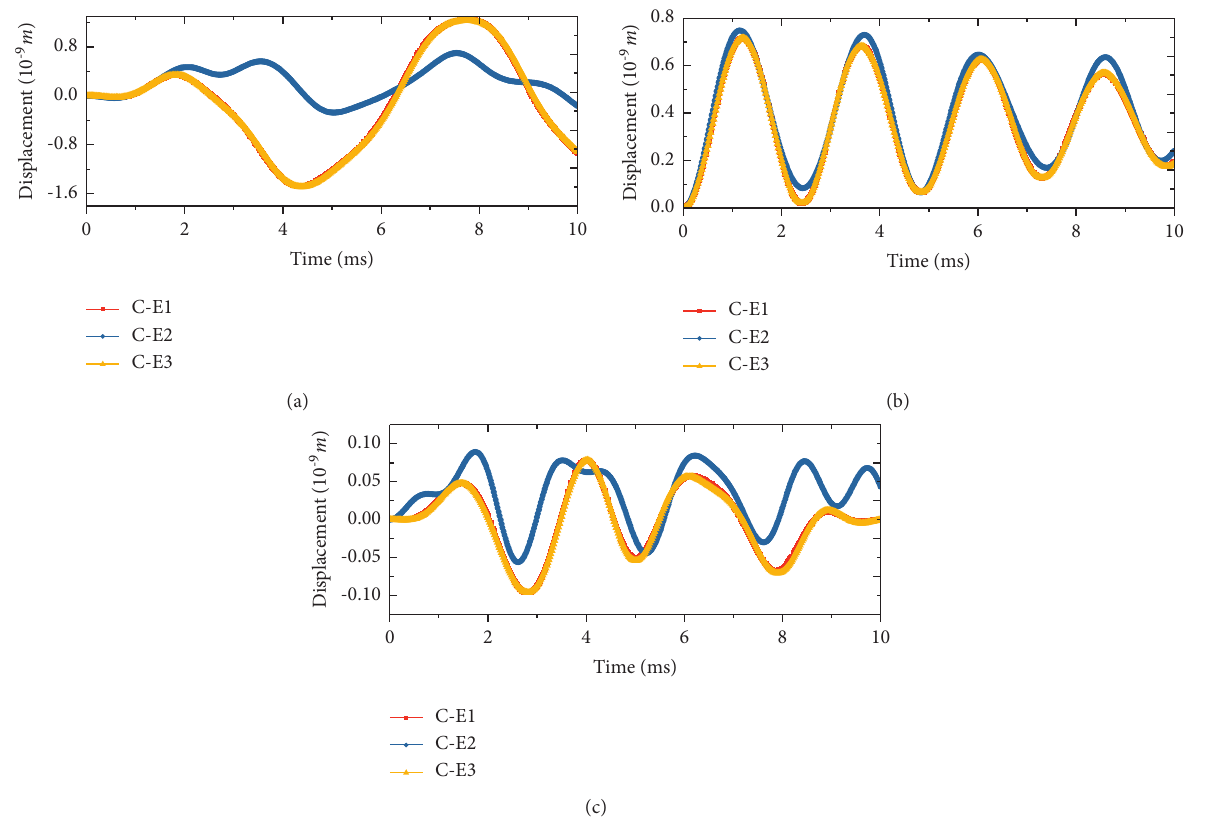
Figure 11: Study on the influence of elastic boundary conditions on the transient response of Sandwich FGP doubly curved structure: (a) Sandwich FGP paraboloidal shell; (b) Sandwich FGP hyperbolic shell; (c) Sandwich FGP elliptical